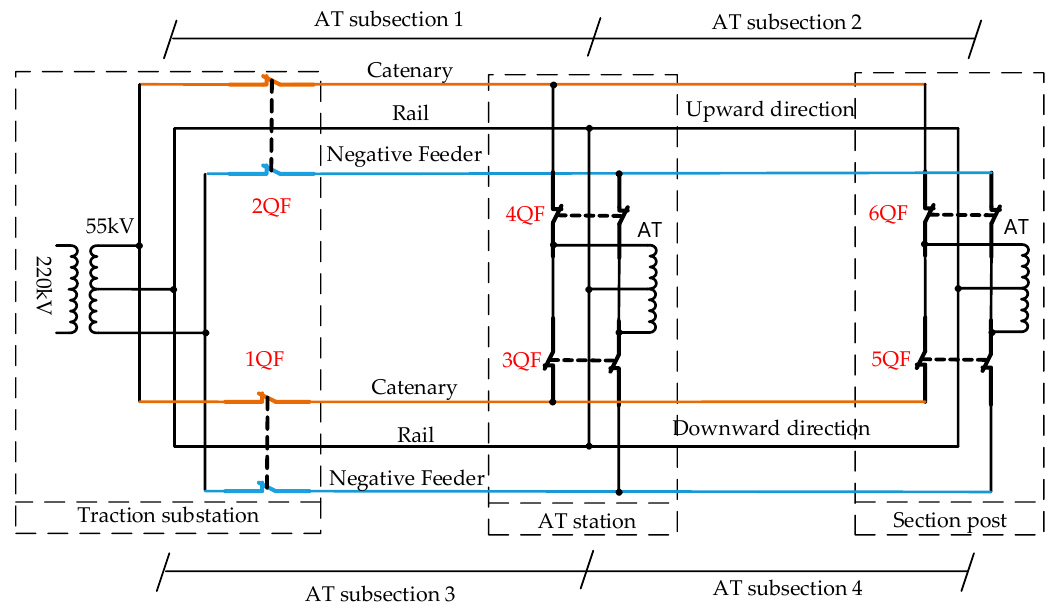
Figure 1. Simplified diagram of the conventional all parallel autotransformer (AT) traction power supply system (TPSS) with four AT subsections.